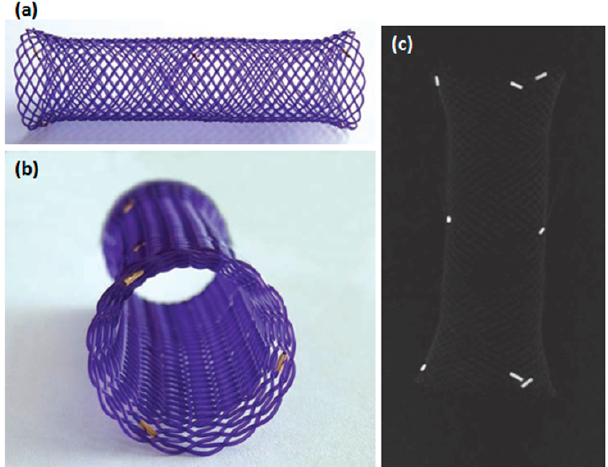
Figure 4. The EllA BD stent (Ella-SX, s.r.o., Hradec Kralove, Czech Republic) is uncovered and made of polydioxanone ( a , b ). The EllA BD stent has radiopaque markers on both ends and in the center ( c ) [43]. It is the markers that the stent is radiotransparent and it letsstents release convenient and visual. Copyright permisson from Taylor & Francis.